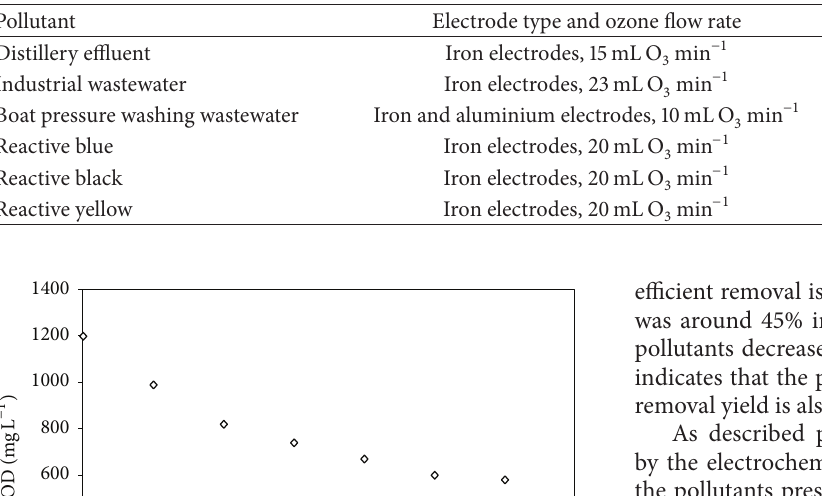
Table 1: Pollutant removal efficiency with a combined process is applied.